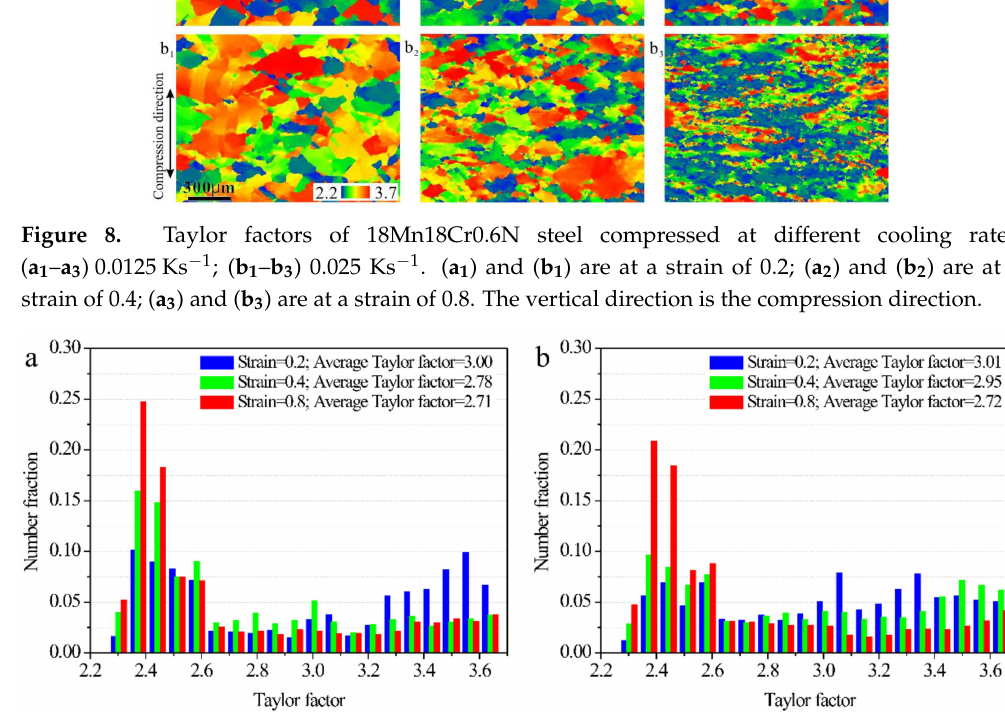
Figure 9. Distribution of Taylor factors of specimens deformed at cooling rates of ( a ) 0.0125 Ks − 1 and ( b ) 0.025 Ks −